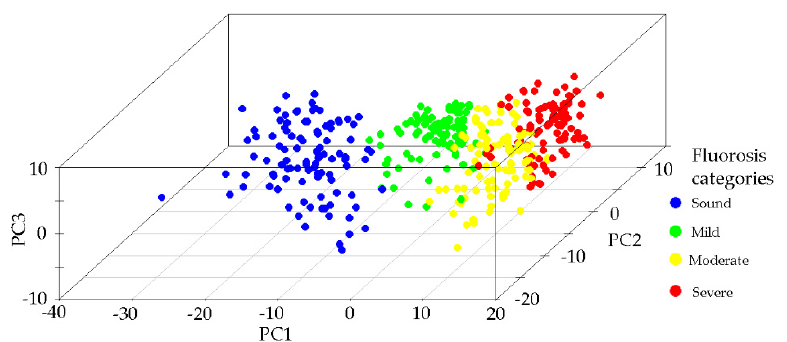
Figure 4. Principal component analysis (PCA). Scatter plot in the 3D PCA space of the Raman spectra according to the fluorosis category.